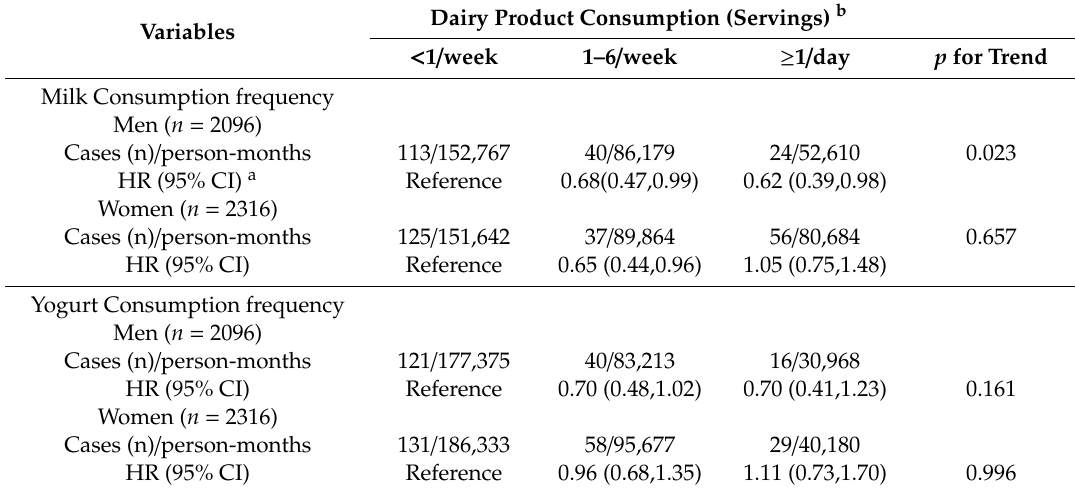
Table 4. Hazard ratios (HRs) and 95% confidence intervals (95% CIs) for the risk of developing a low SMI according to milk and yogurt consumption frequencies at